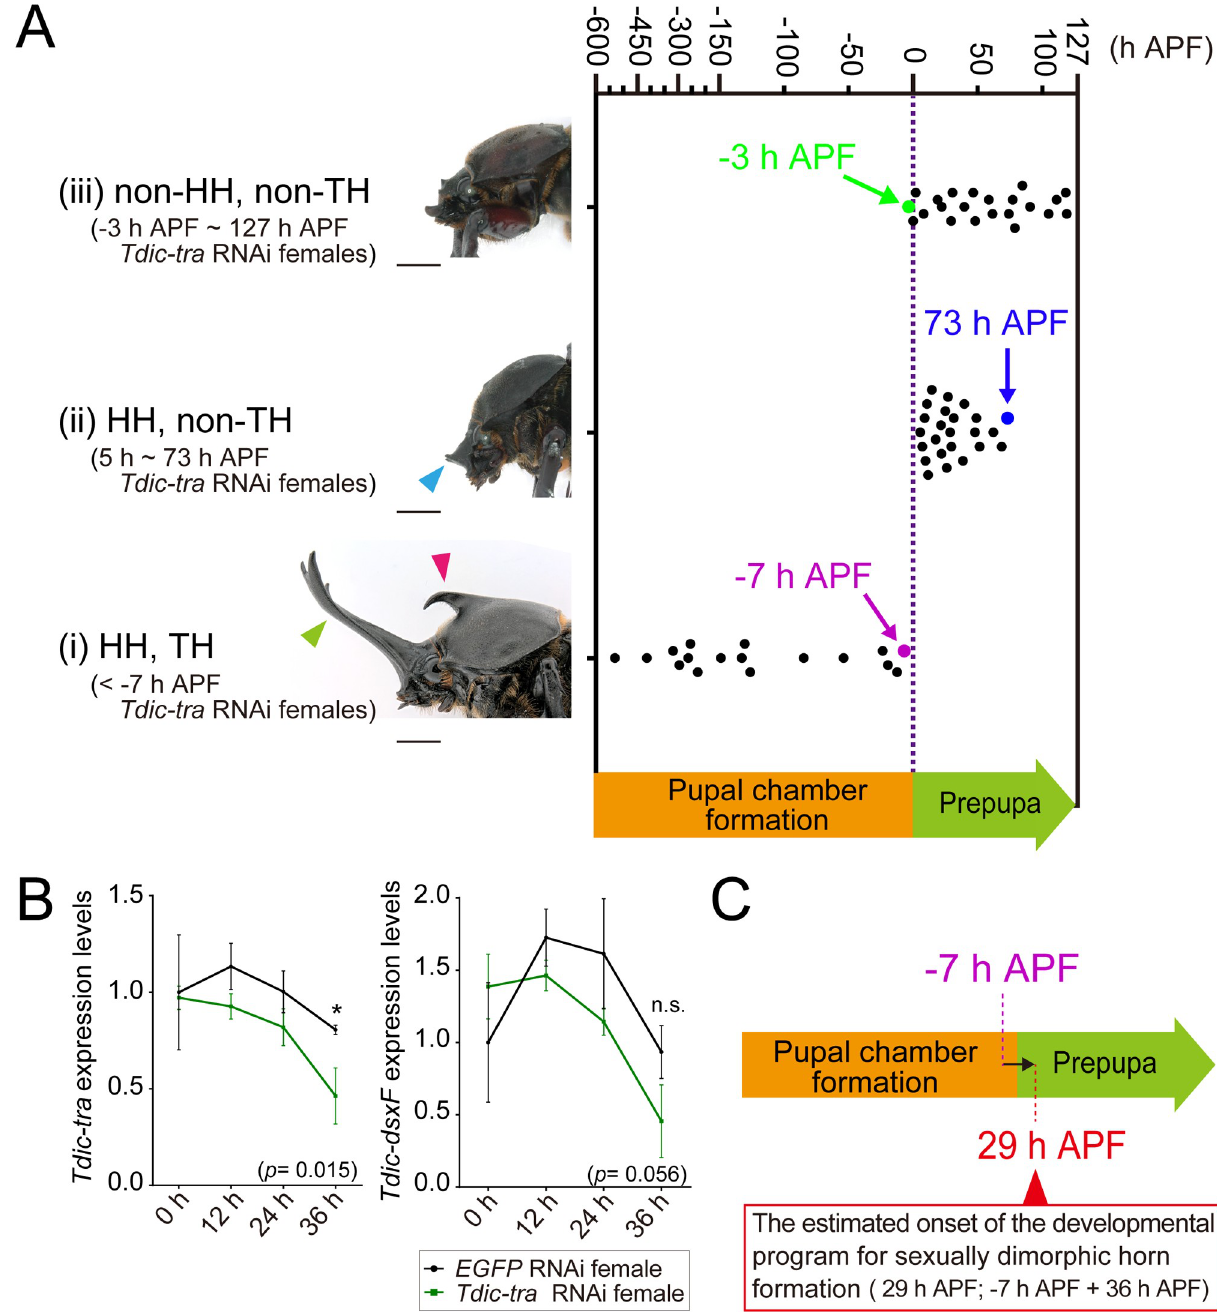
Fig 4. Estimation of the onset of the Tdic - dsx dependent horn developmental program by Tdic-tra RNAi. (A) Relationship between the timepoints of Tdic-tra dsRNA injection and the extent of sex transformation. The extent of the sex transformation (masculinization) phenotypes of Tdic-tra RNAi females were categorized into three classes: (i) prominent HH and TH were formed ( < -7 h APF); (ii) only small HH was formed (5 h APF ~ 73 h APF); (iii) neither the HH nor TH was formed as in normal females (-3 h APF ~ 127h APF). HH, head horn primordia; TH, thoracic horn primordia. The dot plot panel was timepoints of Tdic-tra dsRNA injection before pupation in each class. The green dot, the magenta dot, and the blue dot indicate -3 h APF, -7 h APF and 73 h APF, respectively. Scale bars are 5 mm. (B) Time course of relative Tdic-tra and Tdic-dsxF mRNA expression level after Tdic-tra dsRNA injection at 24 h APF. mRNA expression levels at each timepoint were quantified by qRT-PCR. The expression levels of Tdic-tra were significantly decreased at 36 hours after injection (p < 0.015). The expression level of Tdic-dsxF tended to be decreasing as time went on, but there were no statistically significant difference (p < 0.056). (C) Summary of sex transformation phenotypes and the estimated onset of the Tdic-dsx dependent horn developmental program. The magenta line is the boundary timepoints of phenotype (i). Red arrowheads indicate the timepoints corrected by the mRNA degradation delay (36 hours), which estimated by qRT-PCR. APF, after puapal-chamber formation; Red arrowhead, the estimated onset of the developmental program for sexually dimorphic horn formation driven by Tdic-dsx . https://doi.org/10.1371/journal.pgen.1008063.g004 PLOS Genetics | https://doi.org/10.1371/journal.pgen.1008063 April 10,